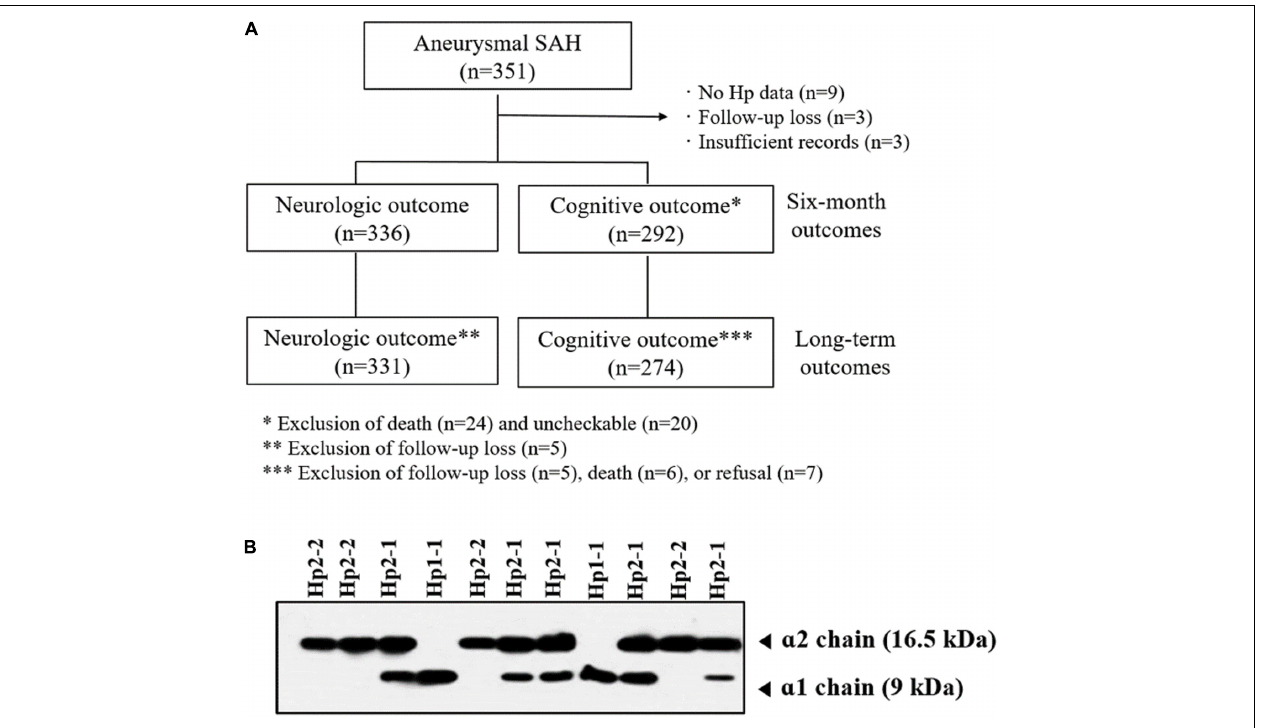
FIGURE 1 | (A) Flow chart outlining the study protocol. (B) Western blotting analysis of haptoglobin (Hp) phenotype. TABLE 1 | Demographic and clinical characteristics of patients with subarachnoid hemorrhage according to haptoglobin (Hp)